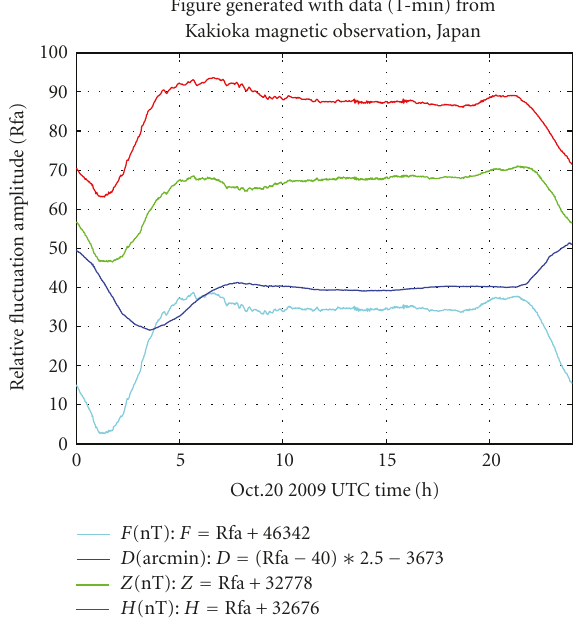
Figure generated with data (1-min) from